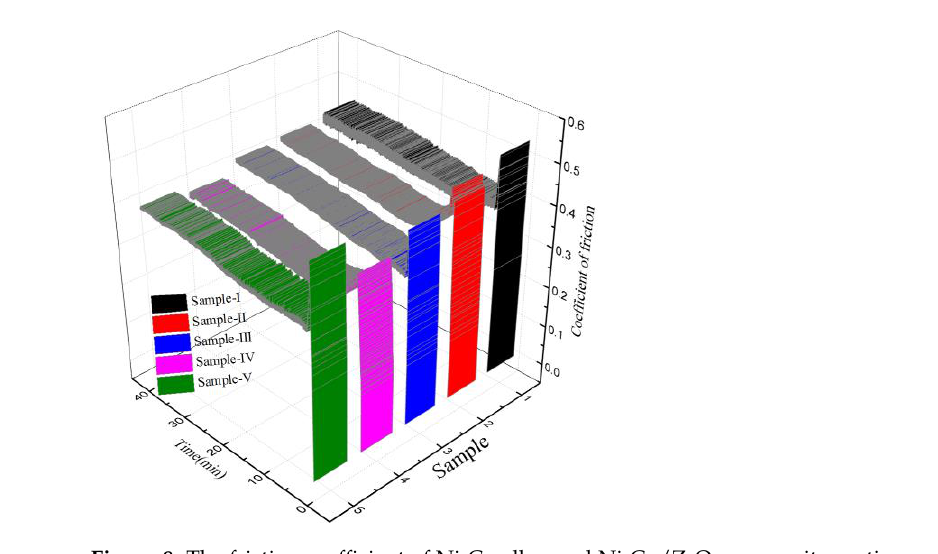
Figure 8. The friction coefficient of Ni-Co alloy and Ni-Co/ZrO 2 composite coatings prepared under different external fields.